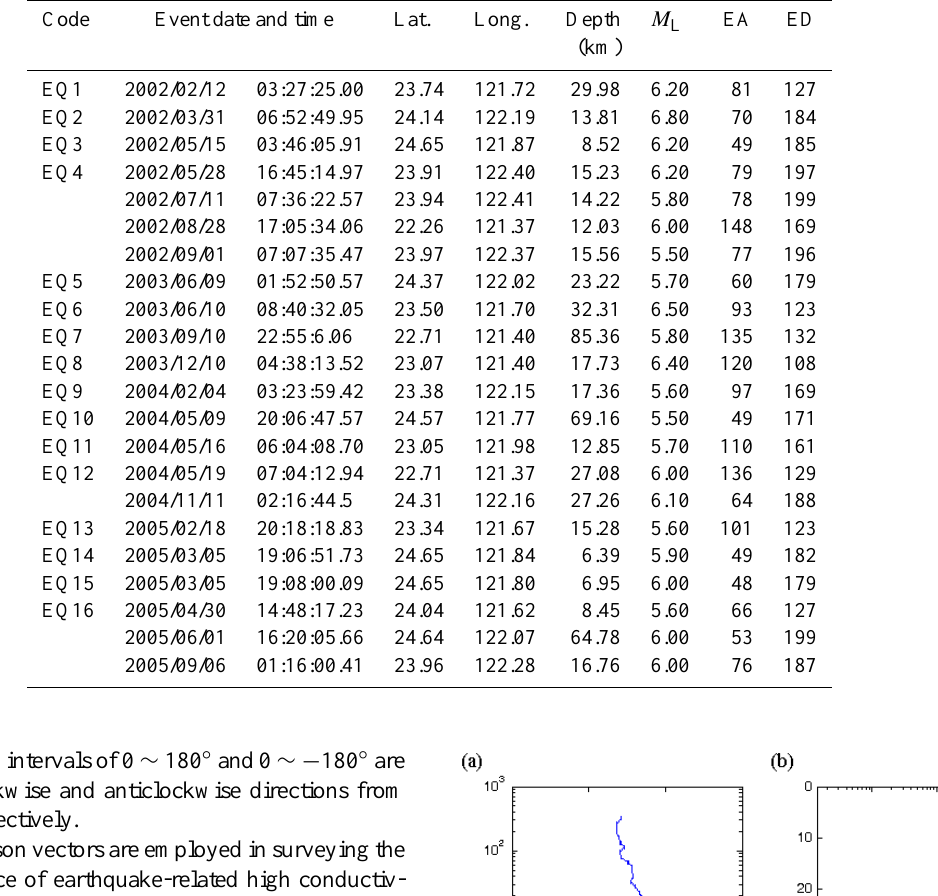
Table 1. M ≥ 5 . 5 earthquake catalogue of Taiwan during the period of 2002–2005 acquired from the broadband array in Taiwan for seis- mology (BATS; http://bats.earth.sinica.edu.tw/). Relocated data (Engdahl et al., 1998) for the earthquakes were retrieved from the Central Weather Bureau in Taiwan. Since geomagnetic data gaps existed for 6earthquakes, residuals of 16earthquakes are utilised. Note that ED and EA denote epicentral distance and epicentre azimuths to the CCU station.